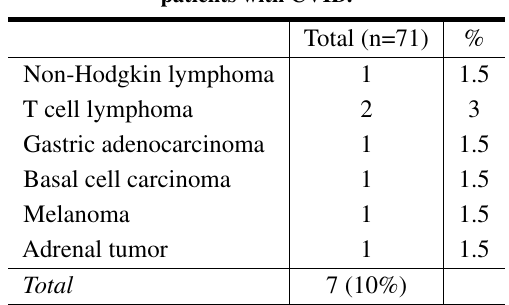
Neoplasias developed in a cohort of Brazilian patients with